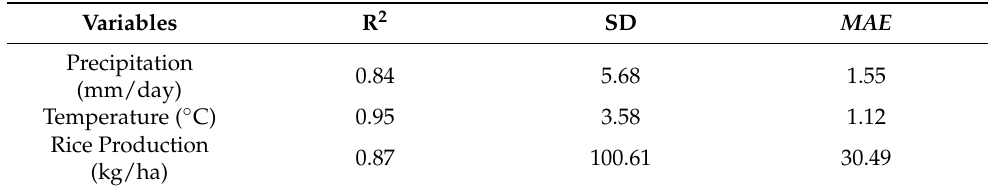
Table 3. Statistics comparing the model and observations.